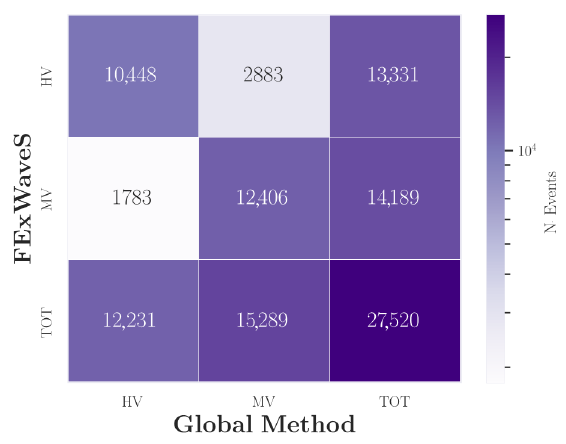
Figure 9. Origin assessment: Global Method and FExWaveS outcomes.